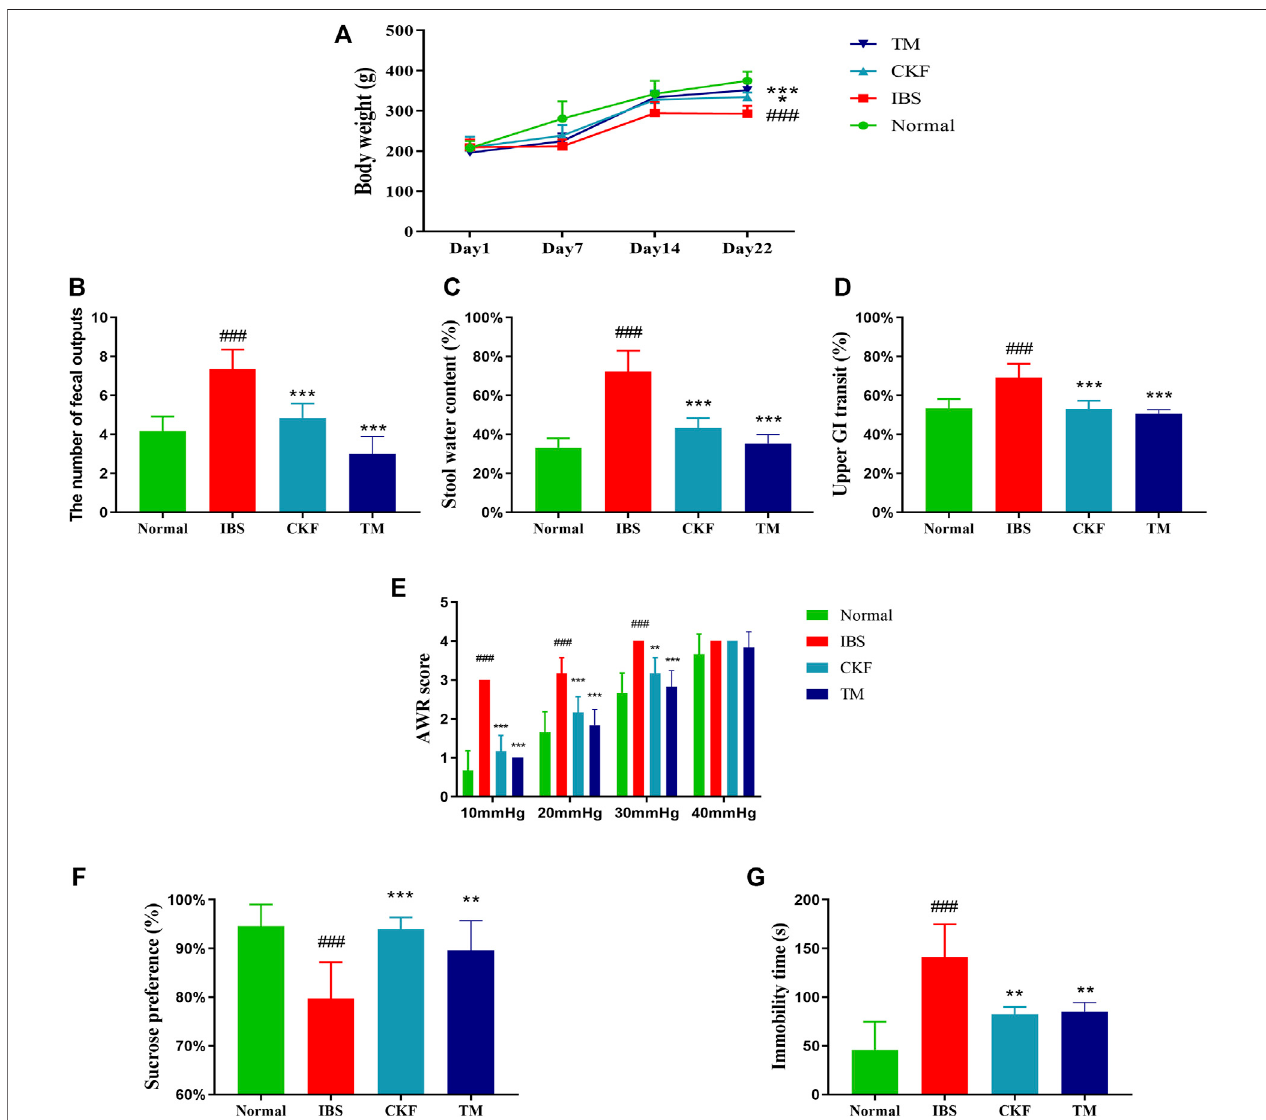
FIGURE2| Chang-Kang-Fangformulaaffectsthebodyweight,theoccurrenceofdiarrhea,intestinaltractmotility,abdominalwithdrawalre fl ex(AWR),thesucrose preferencetest(SPT),and forcedswimmingtest(FST)inIBSrats (A) Thechangesinthebodyweights ofrats. (B) Fecaloutput (C) stoolwatercontent (D) Intestinaltract motility. (E) AWR scores. (F) Percentage of sucrose water consumed in the SPT. (G) The immobility time ofrats in FST. Values are presented as the means ± SD ( n = 8). ### p < 0.001 compared to Normal, * p < 0.05, ** p < 0.01 and *** p < 0.001 compared to